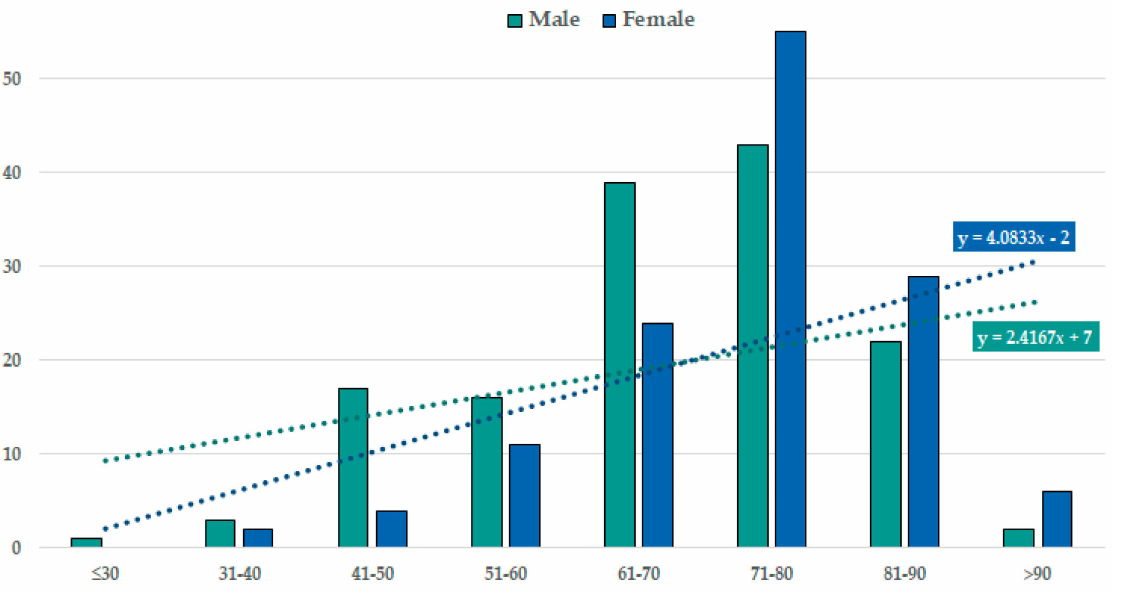
Figure 5. Age-group distribution based on